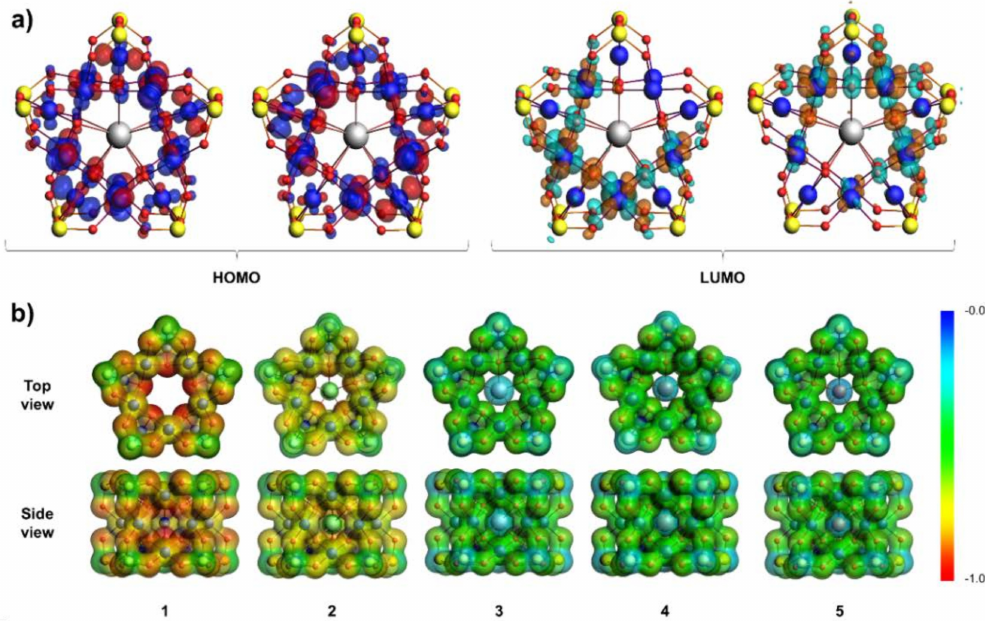
Figure 2. ( a ) The doubly degenerate highest occupied molecular orbital (HOMO) and the lowest unoccupied molecular orbital (LUMO) of 1-La which is also representative for 1-Gd and 1-Lu ; ( b ) molecular electrostatic potential plotted over the density isosurface of polyanions 1 – 5 . The most negative potentials are colored in red. All calculations are performed at (U)B3LYP/TZ2P/ZSC/COSMO-water level. Color code: Se = yellow, Pd = blue, O = red, and Ln = grey